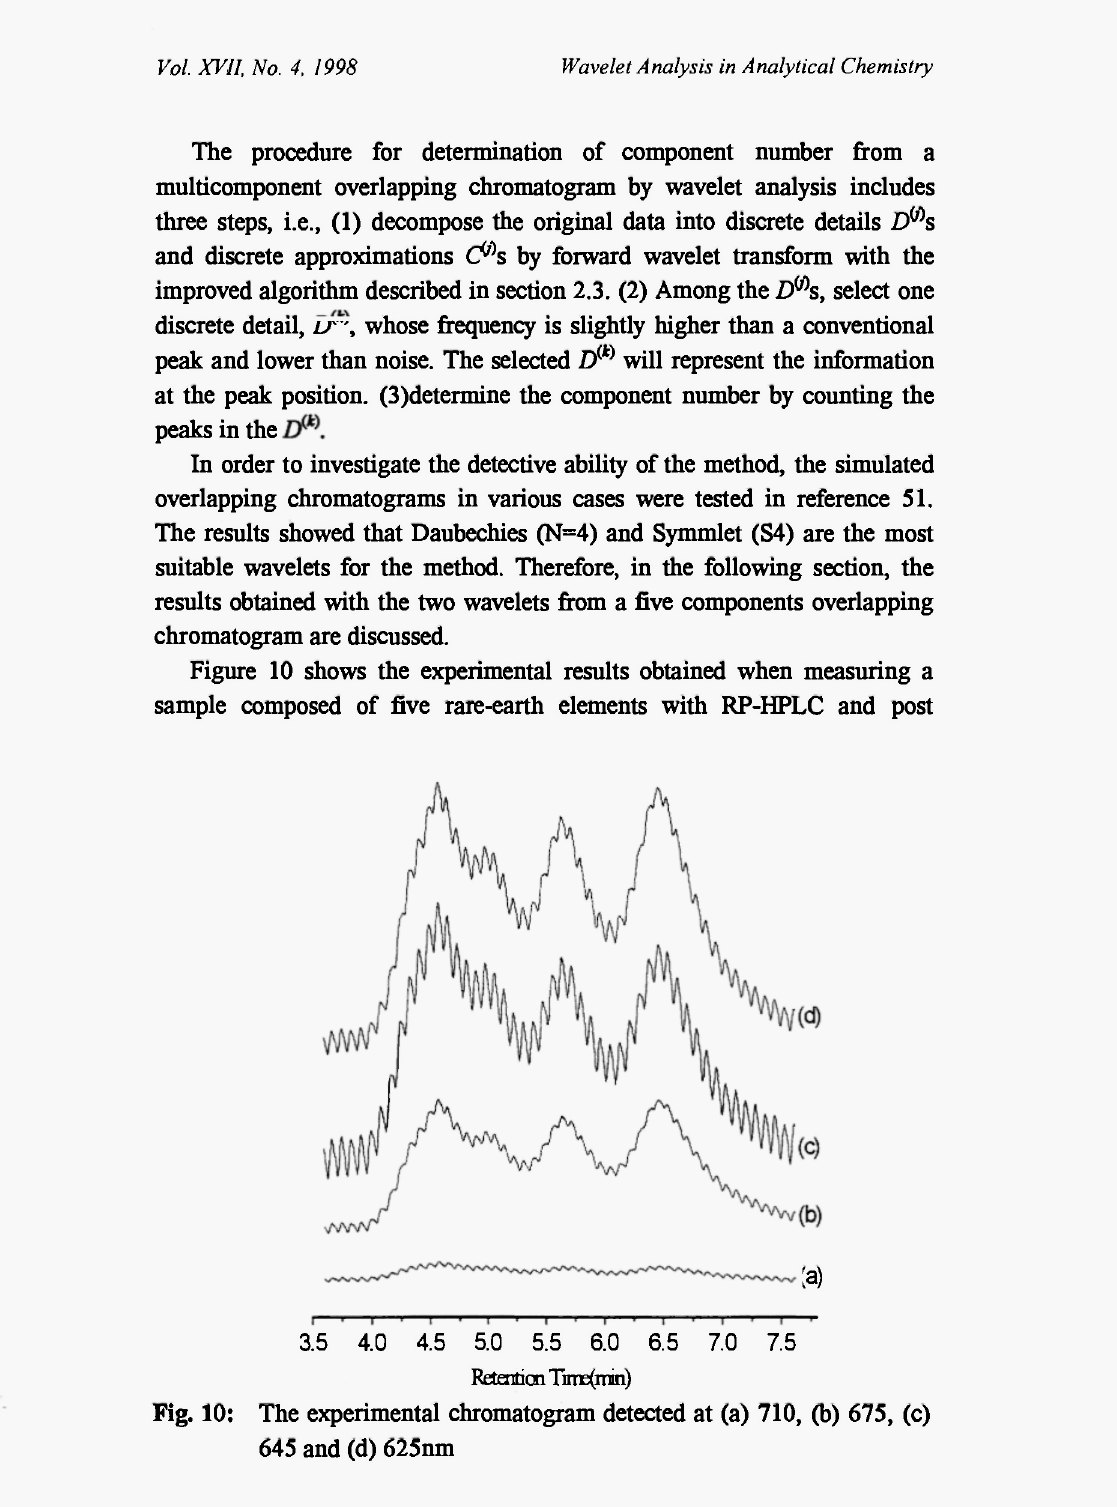
Fig. 10: The experimental chromatogram detected at (a) 710, (b) 675, (c) 645 and (d)